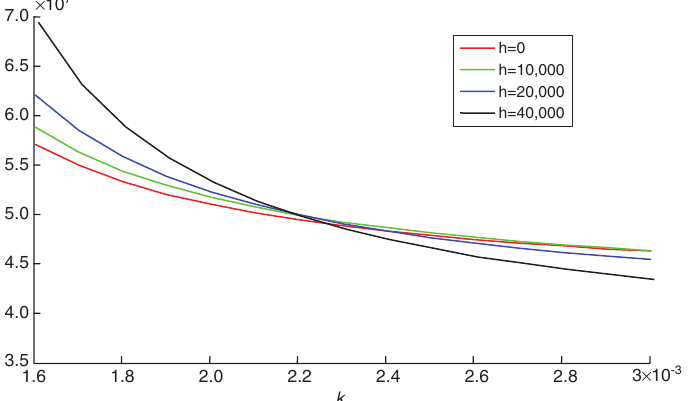
Figure 4 Variation of the phase velocity Real(c) against the wave number k for a fixed inhomogeneity parameter ε = 0.0015.